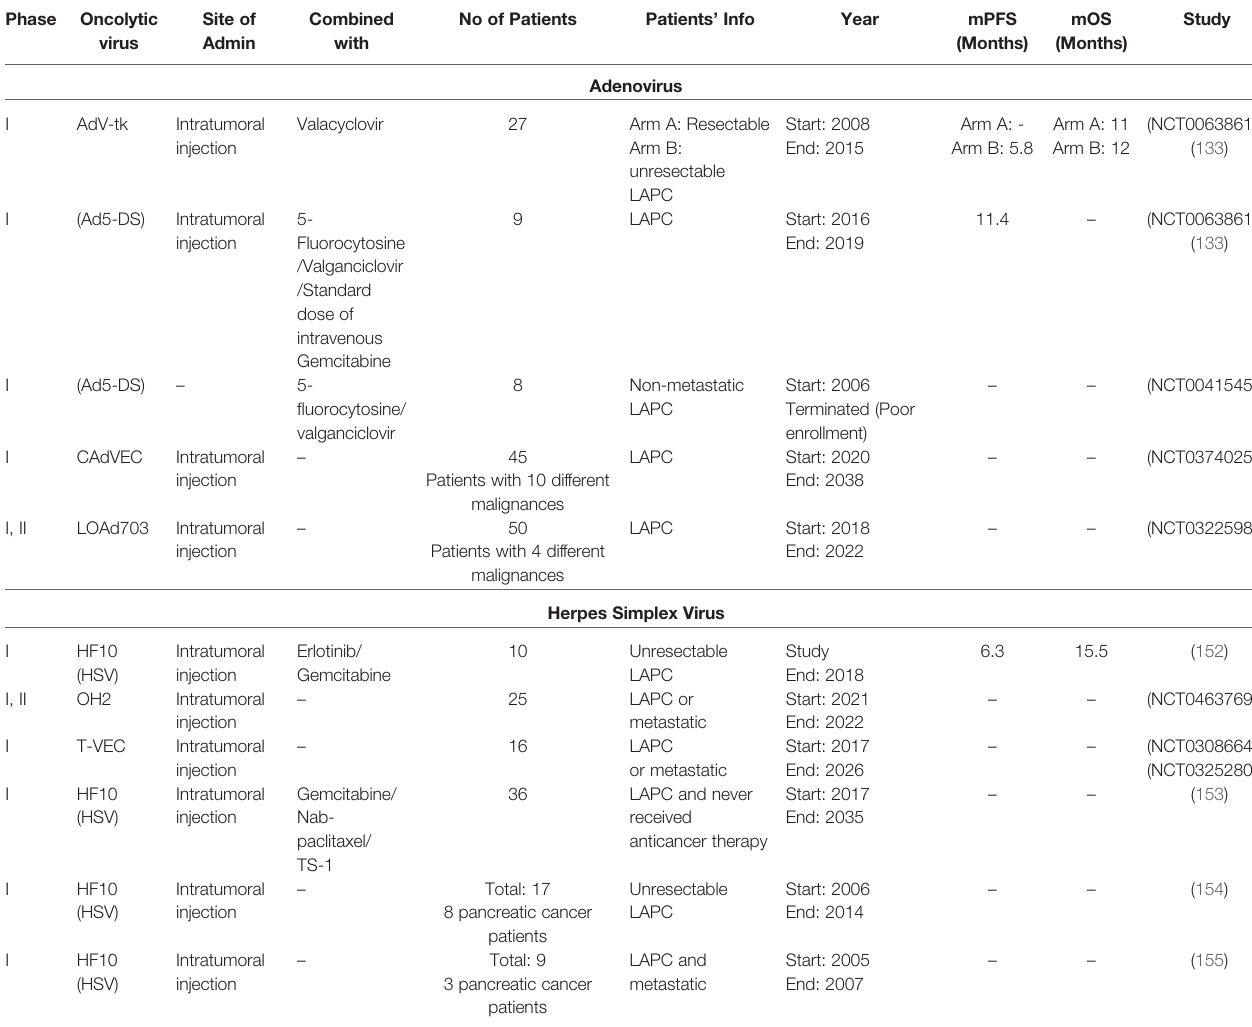
TABLE 1 | Clinical trials for assessing the oncolytic adenovirus and Herpes Simplex Virus therapy effect in patients suffering from pancreatic cancer. Phase Oncolytic